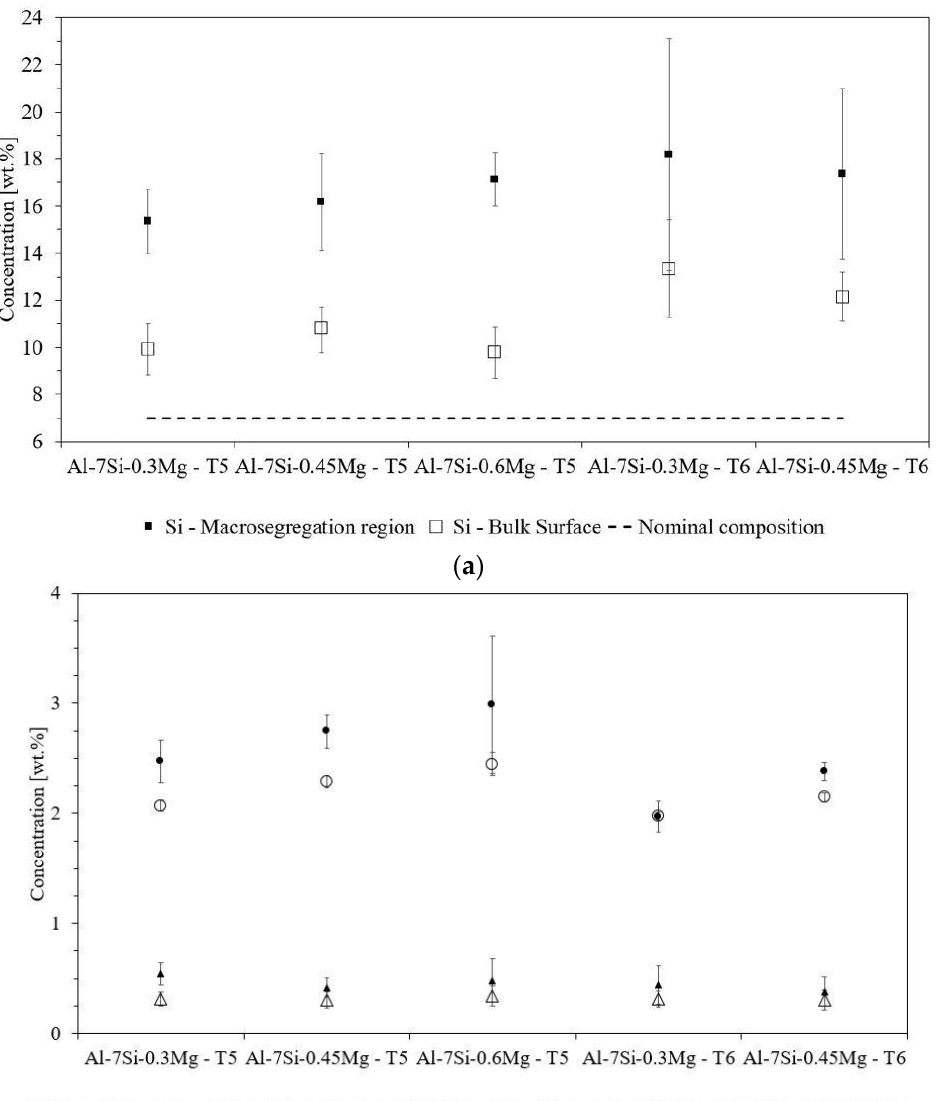
Figure 10. Concentrations of elements in the regions of macrosegregation and bulk surface measured by EDS: ( a ) silicon and ( b ) magnesium and iron. The horizontal, dashed line in ( a ) indicates the silicon nominal composition of the